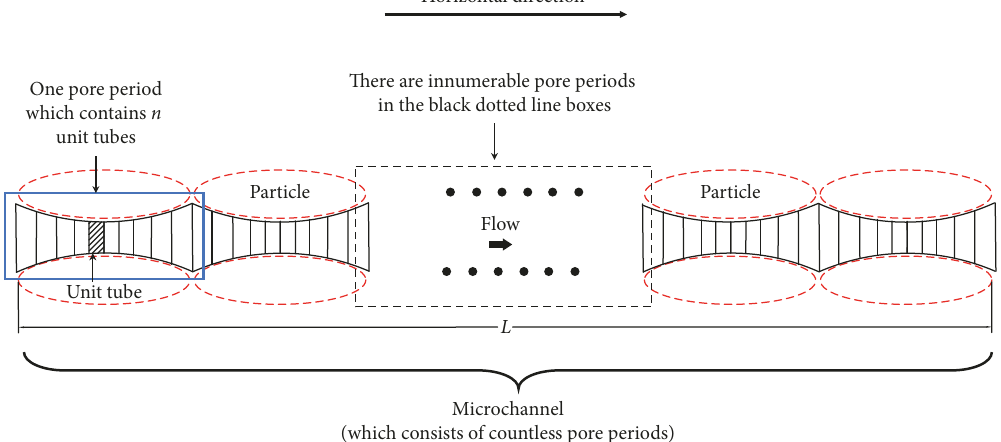
Figure 3: Various pore elements in the horizontal direction (unit tube, pore period, and